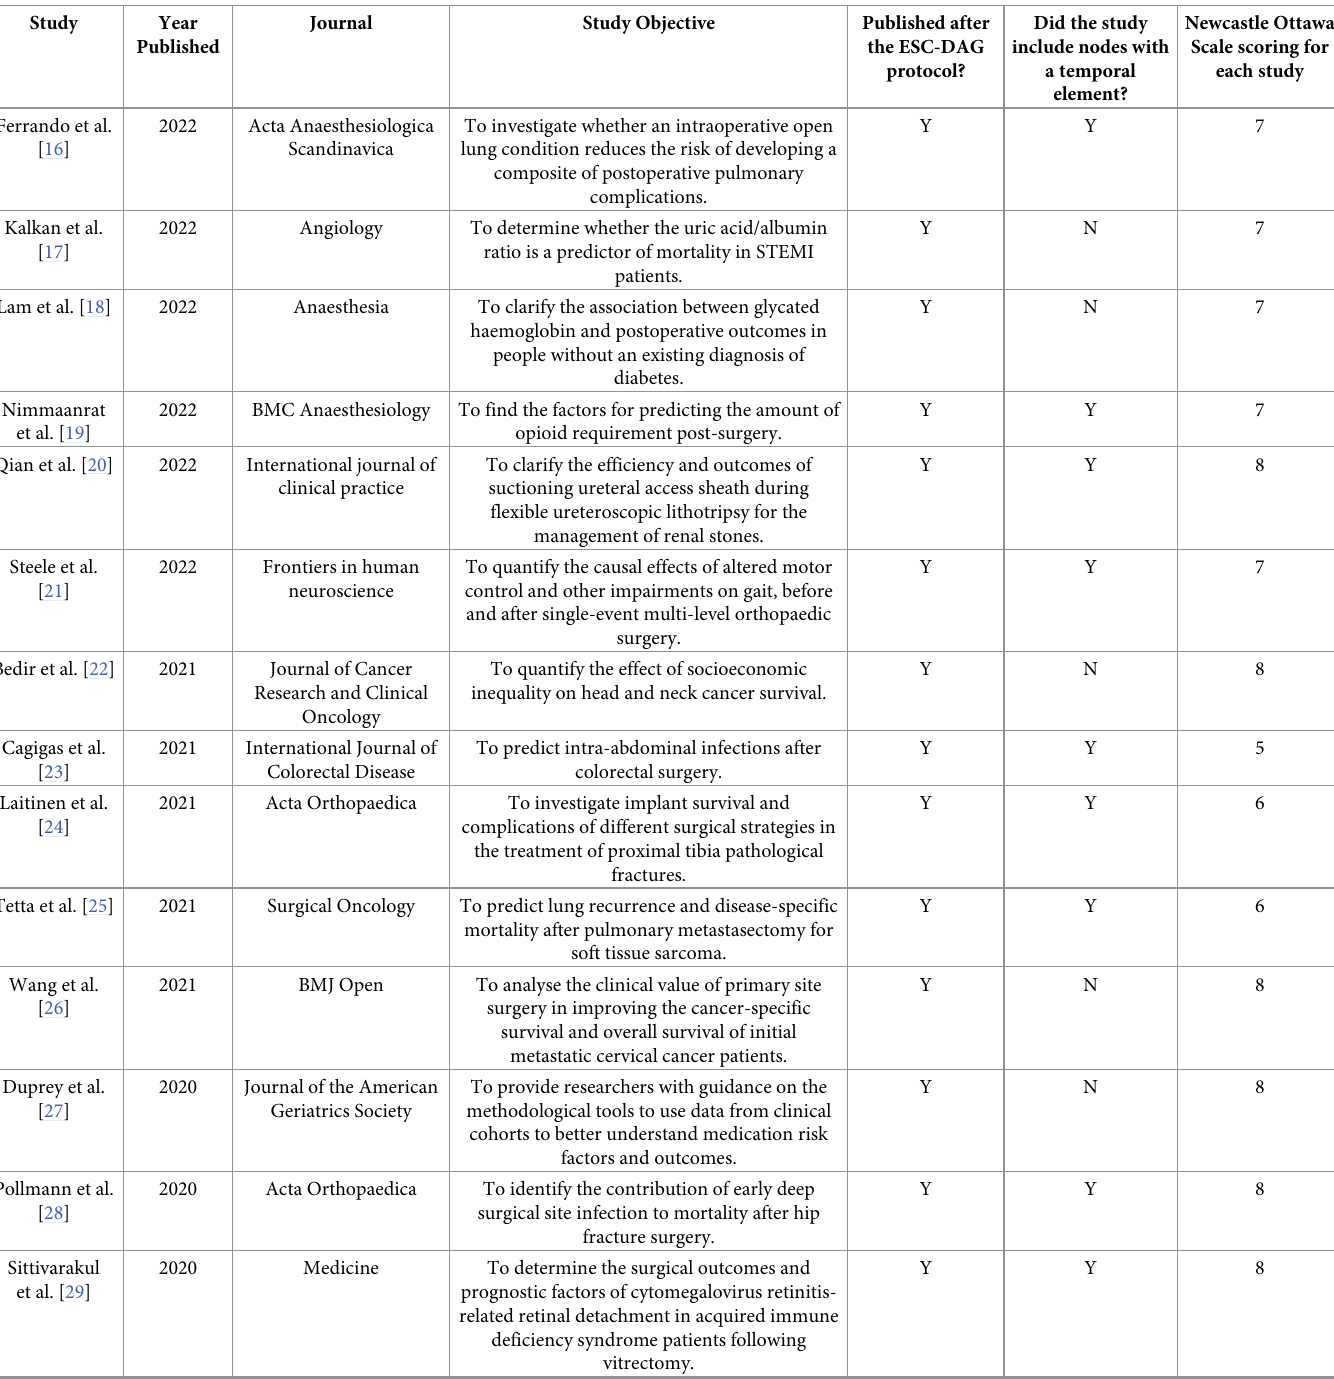
Table 2. Table depicting the year, journal, study objective and publication date relative to the ESC-DAG protocol of the final nineteen studies. Whether the DAG within the study included a temporal variable is also recorded. A study including temporal variables means this study acknowledged or specified that a certain variable e.g., drug usage was measured at a specific time point in the preoperative pathway.